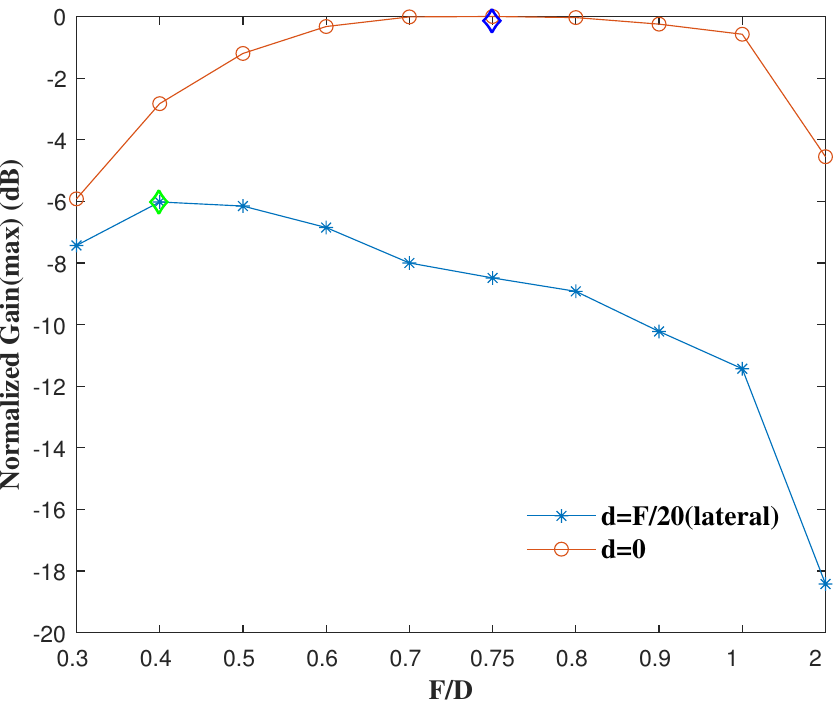
Figure 9. Peak gain of each F / D with d = F /20 (lateral) compared to d = 0. When F / D = 0.75, the far-field patterns of feed lateral displacement at 0, 0.5 λ (axial), 0.5 λ (lateral), 0.75 λ (lateral) and λ (lateral) are shown in Figure 10. This simulation was carried out to analyze the effect of feed displacement at the initial optimum F / D = 0.75. The gain changes were expected and consistent with the results above. Axial displacement